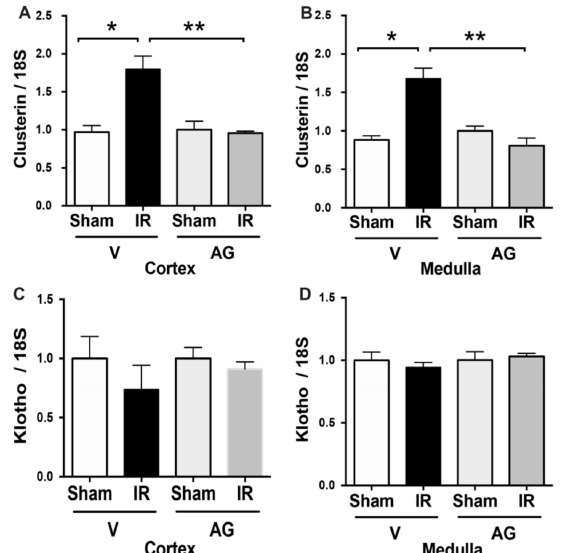
Figure 3. AG inhibited the upregulation of clusterin mRNA observed during IR, but not for klotho. BALB/c mice were treated with either vehicle or AG (50 mg/kg i.p) before sham or subjected to 30 min of ischemia and 48 h of reperfusion (IR). The clusterin and the klotho mRNA expressions were determined by qPCR in sham (n = 5), IR (n = 5), AG-sham (n = 6), and AG-IR (n = 6). ( A ) Clusterin mRNA in the cortex. ( B ) Clusterin mRNA in the medulla. ( C ) Klotho mRNA in the cortex ( D ) Klotho mRNA in the medulla. The bar graphs represent mean ± SEM, and the data were analyzed using ANOVA and non-parametric Kruskal–Wallis test. * p < 0.05, ** p < 0.005.